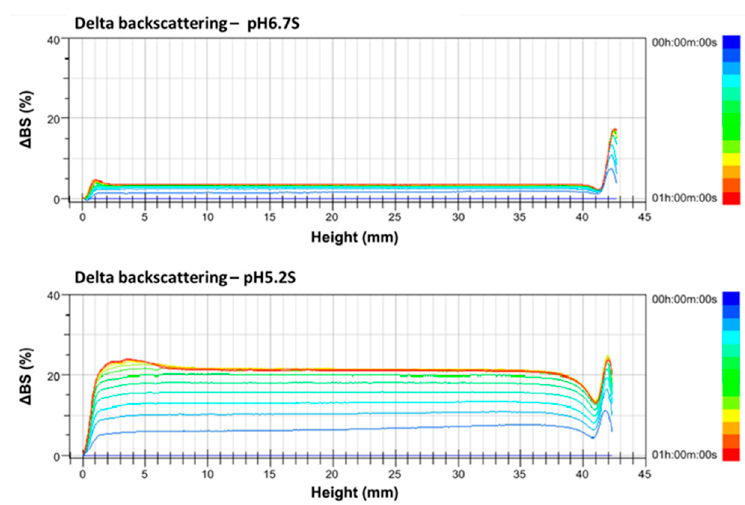
Figure 3. Delta backscattering profiles of pH 6.7 and 5.2 of skimmed Alpine goat milk. The data are reported as a function of time (0–60 min) and sample height (0–42 mm).